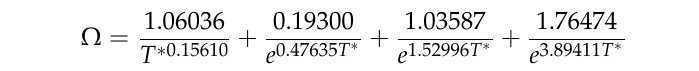
Table 2. Lennard-Jones parameter used for the calculation of the binary diffusion coefficient. O